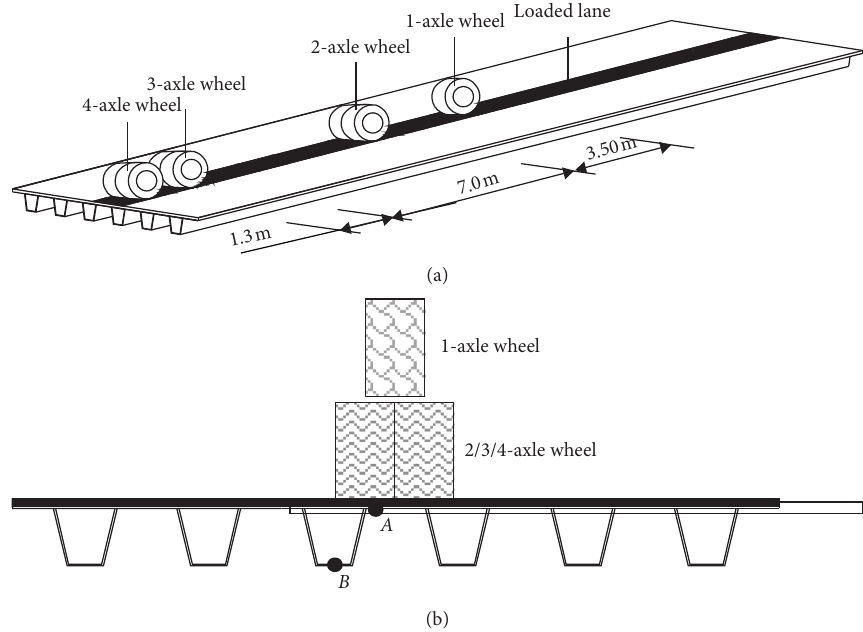
Figure 2: Loading locations and measuring points: (a) wheel load in the longitudinal direction and (b) wheel load in the transversal